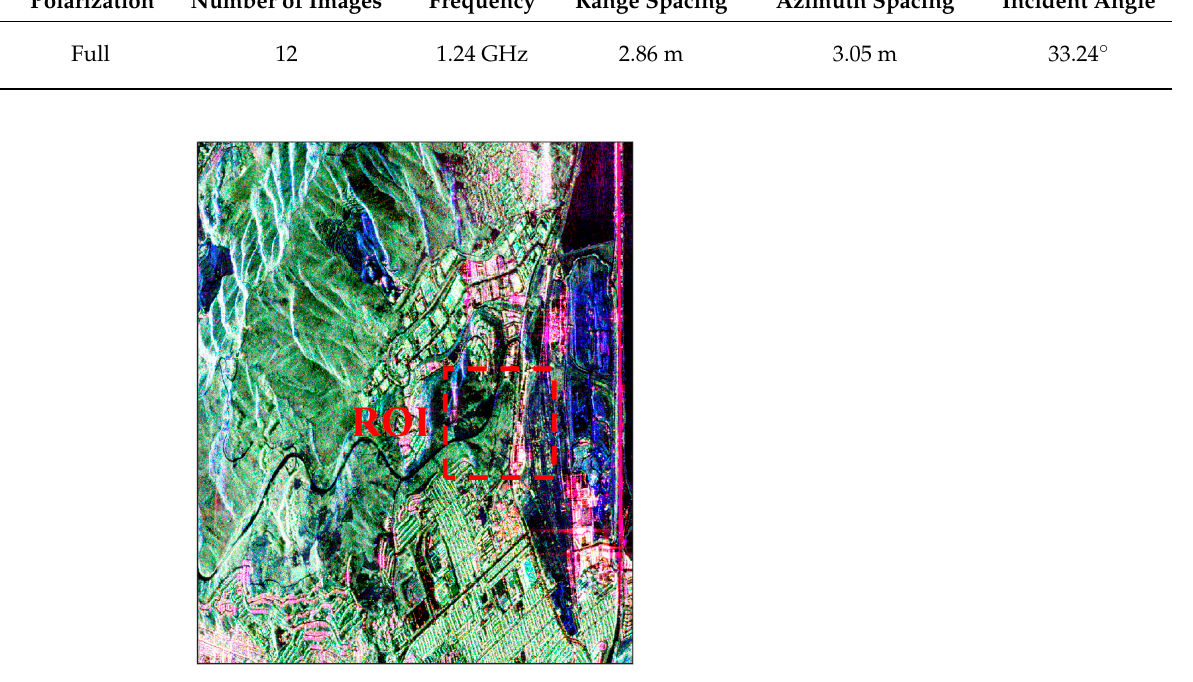
Figure 3. Temporally averaged PauliRGB image of ALOS PALSAR-2 TSPolInSAR data. The region of interest (ROI) (250 × 250 pixels) marked by the dotted box is selected for the following further investigation in Section 4.3.